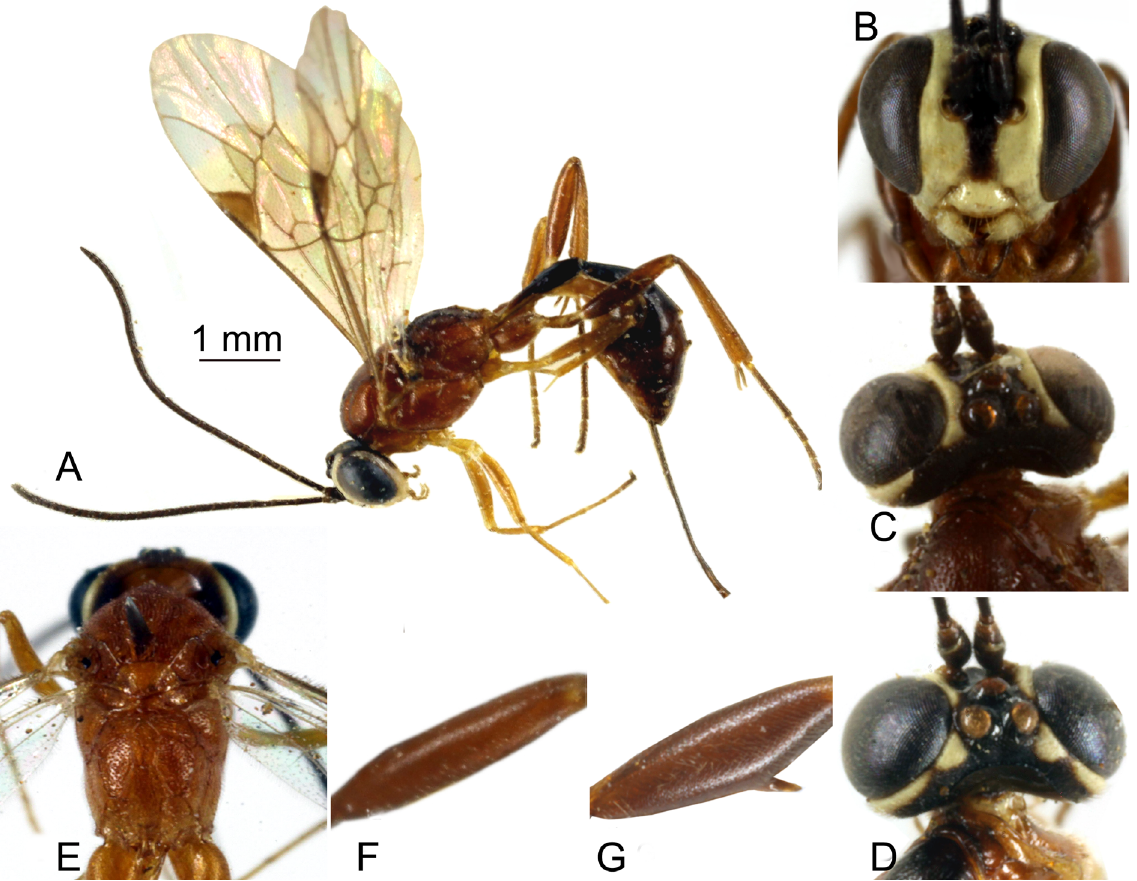
Fig. 4. Pristomerus caris Fitton, 1994. A . ♀, habitus, profile. B . ♀, head, facial. C . ♂ (paratype), head, dorsal. D . ♂ (Ankaratra), head, dorsal. E . ♀, mesosoma, dorsal. F . ♀, hind femur, profile. G . ♂, hind femur,